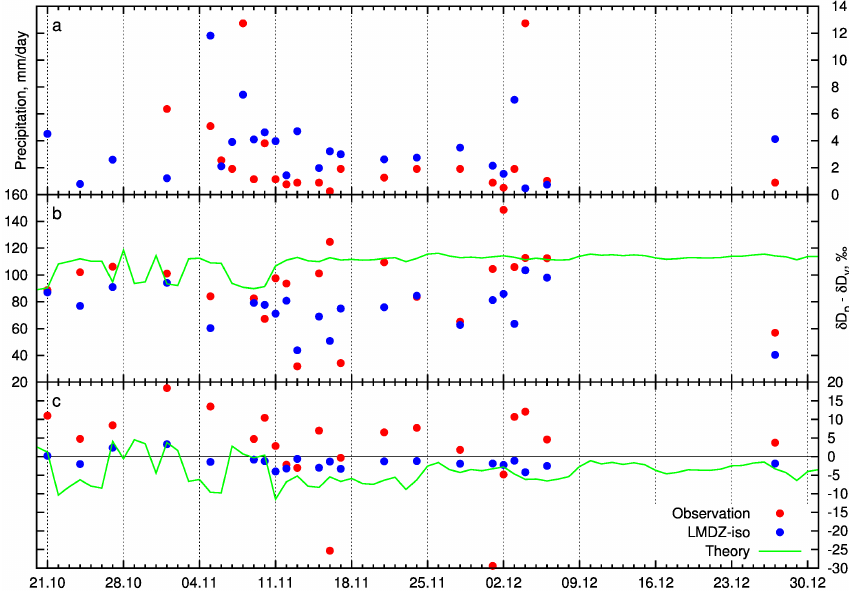
Figure 10. Daily mean difference between precipitation and water vapor δD (a) and d excess (b) for observations in Kourovka (red) and Fig. 10. Daily mean difference between precipitation and water vapor δD (a) and d-excess (b) for LMDZ (blue). The green line represents a theoretical estimation of this observations in Kourovka (red) and LMDZ (blue). The green line represents a theoretical estimation of this difference.